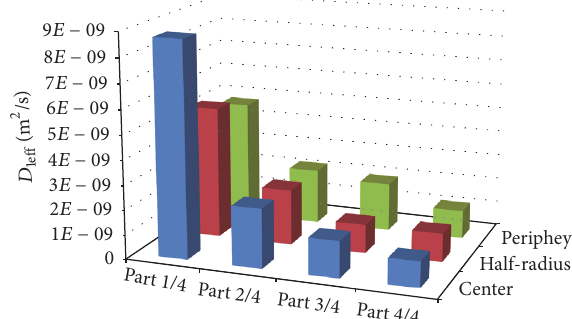
Figure 8: Distribution of the effective diffusion coefficient in the pith of Raffia vinifera in twelve sampling zones during the initial stage.